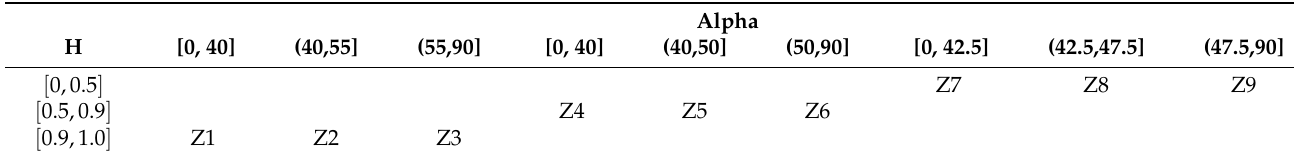
Table 2. Split criteria of the H-Alpha plane.